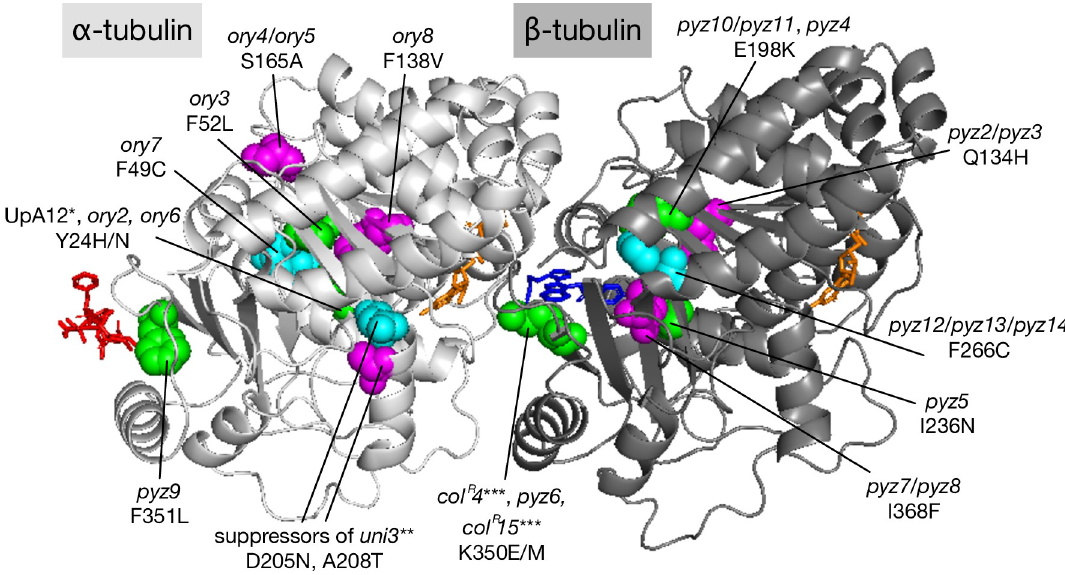
Fig 5. Predicted three-dimensional structure of Chlamydomonas reinhardtii α / β -tubulin heterodimer showing the mutations reported in the present and previous studies. Light gray, α -tubulin; dark gray, β -tubulin. Altered amino acids are shown as sphere representations. The binding sites of tubulysin M (red, an oryzalin-like compound) and 2RR (blue, 3-[(4-{1-[2-(4-aminophenyl)- 2-oxoethyl]-1H-benzimidazol-2-yl}-1,2,5-oxadiazol-3-yl)amino]propanenitrile, a propyzamide-like compound) were determined by applying the alignment command in MacPyMol software to the tubulin structures 4ZOL and 4O2A reported in the presence of these compounds [25, 26]. The orange stick representations show GTP (in α -tubulin) and GDP (in β -tubulin). Mutations identical to previously reported mutations are marked with asterisks: � , [3]; �� , [5]; and ��� , [6].